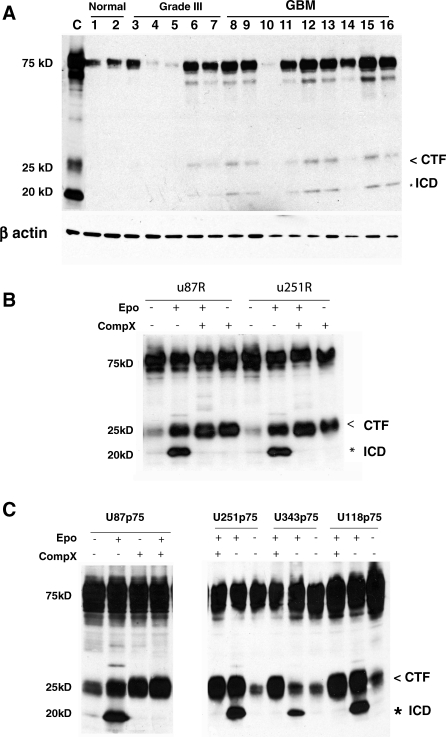
p75NTR Is Proteolytically Processed in Patient Specimens and Invasive Glioma Cells(A) Western blot analysis detected p75NTR-positive fragments migrating at 24 and 19 kDa in patient specimens expressing p75NTR (eight of nine GBMs, two of five Grade III glioma) but was undetectable in tissue from normal human brain. U87 cells transfected with p75NTR and grown in the presence of the proteasome inhibitor epoxomicin (1 μM) were used as a positive control (C). Western blots probed for beta-actin were used as a loading control. Molecular weight markers are indicated on the left.(B) The highly invasive glioma cell lines U87R and U251R isolated by serial in vivo selection were treated with the proteasome inhibitor epoxomicin (Epo, 1 μM) and/or the γ-secretase inhibitor, Compound X (CompX, 2 μM) for 4 h. Western blots for p75NTR were probed with an antibody specific to the cytoplasmic domain of p75NTR which detects full-length (75 kDa), CTF (indicated by the less than symbol [<]; 25 kDa), and ICD (indicated by the asterisk [*]; 19 kDa) peptides. The ICD is derived from the cleavage of the CTF, which is shown to visibly accumulate in the presence of a γ-secretase inhibitor.(C) p75NTR proteolytic processing is a global event in human glioma cells. pcDNA3.1 encoding human p75NTR or the empty pcDNA3.1 vector were stably transfected into U87, U251, U118, and U343. Cells expressing p75NTR (U87p75, U251p75, U118p75, and U343p75) were treated as described above. Western blot analysis showed that all glioma cell lines tested cleaved the full-length p75NTR to generate first the 24-kDa CTF and then the 19-kDa ICD.